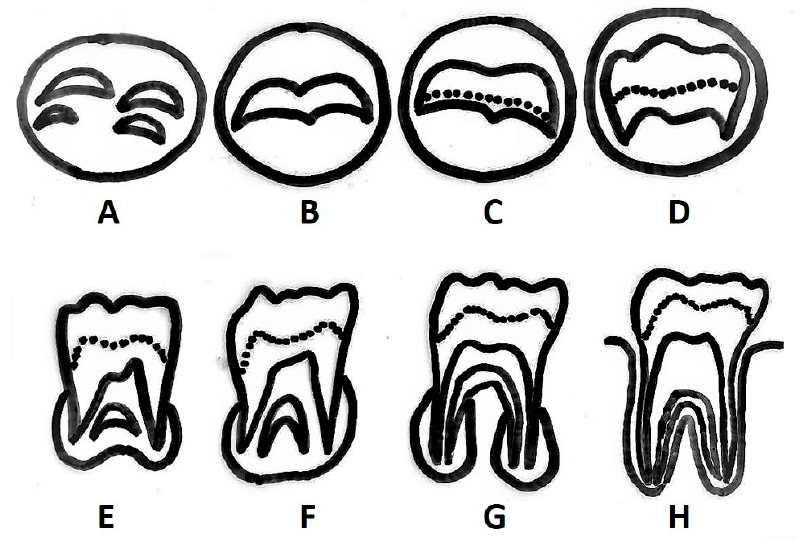
Figure 1. Dental developmental stage according to Demirijian et al. [9]: ( A ) beginning of crown formation; ( B ) the complete and fused tooth crown can be clearly seen; ( C ) half of the crown is complete, and the formation of the pulp chamber can be discerned; ( D ) the crown formation is completed; ( E ) the beginning of the formation of the furcation can be discerned, and the length of the root is smaller than the length of the crown; ( F ) the length of the root is at least the same as the length of the crown; ( G ) developed and parallel root walls can be seen, but the apexes are open; ( H ) the root apexes are closed.